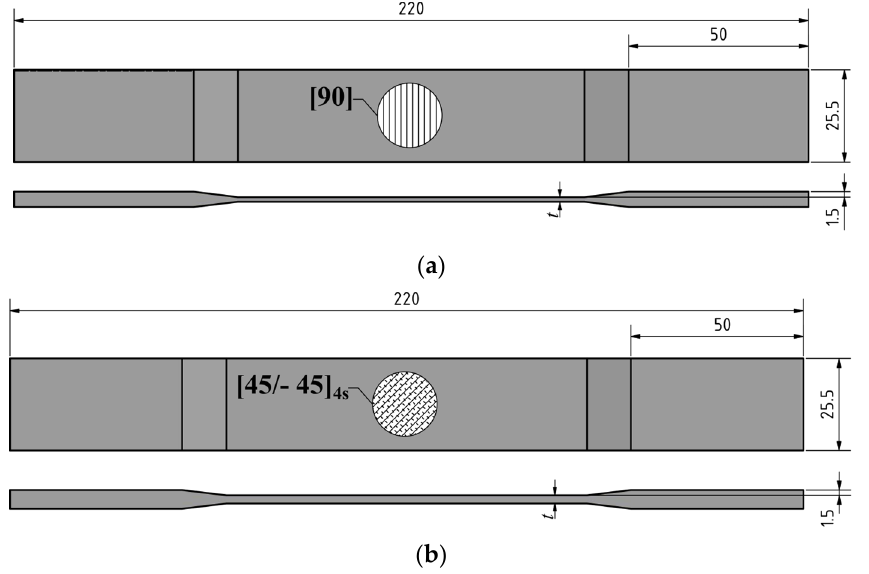
Figure 2. CAE dimensions: ( a ) UD-90 specimen dimensions, and ( b ) SH-45 specimen dimensions; recreated according to [81].